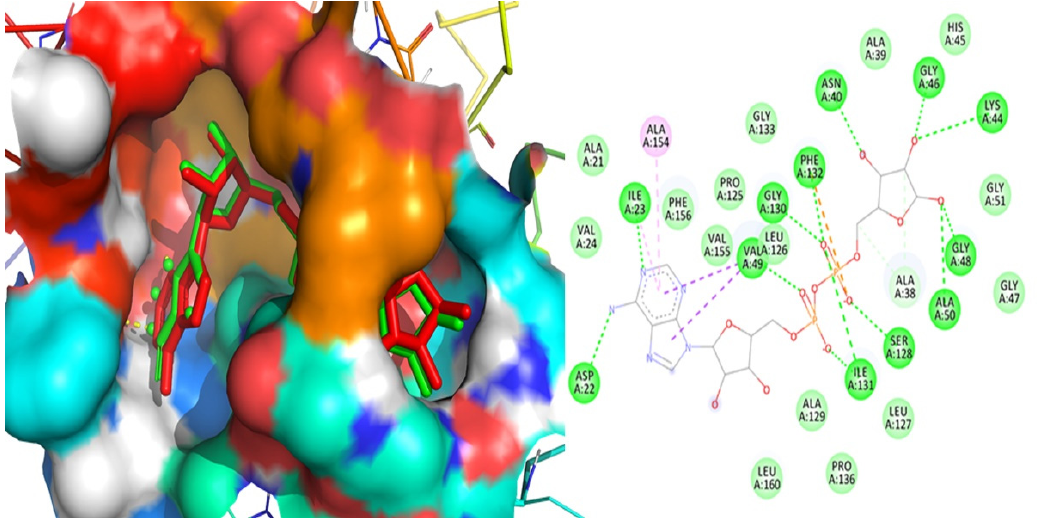
Figure 2. Superimposed conformation of the docked ligand ADP overlaid with its crystallized bio- active conformation and the two-dimensional chemical interaction with the ARP